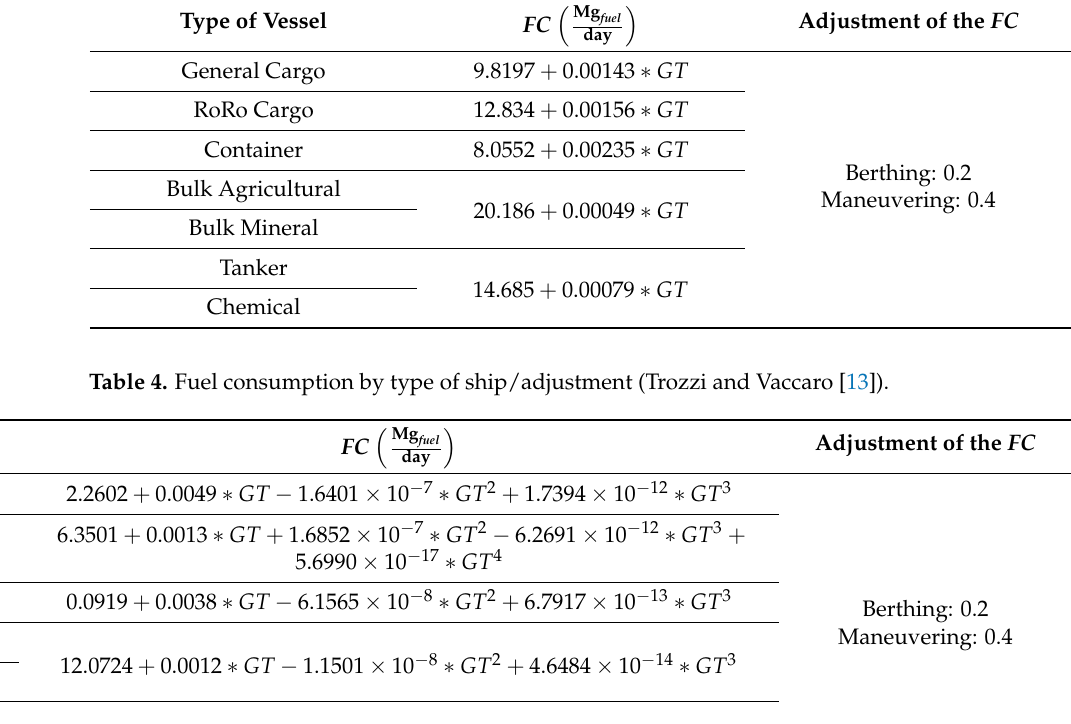
Table 3. Fuel consumption by type of ship (Trozzi and Vaccaro [12]). Type of Vessel